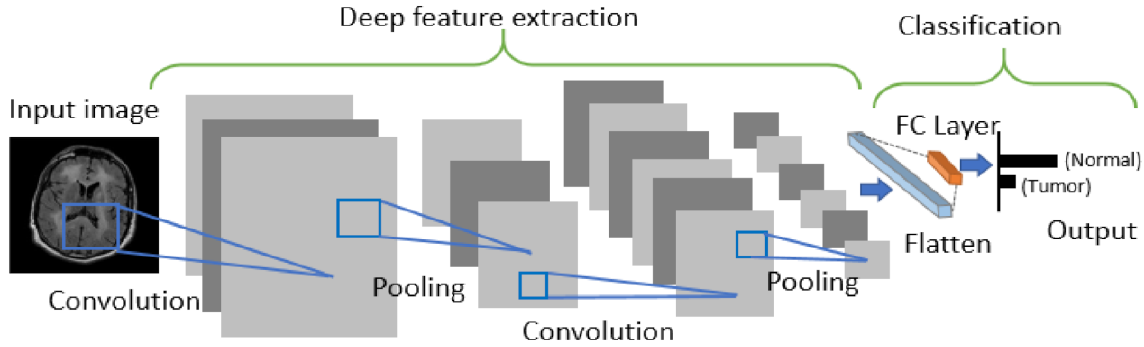
Figure 6. Proposed DLPNN classifier.